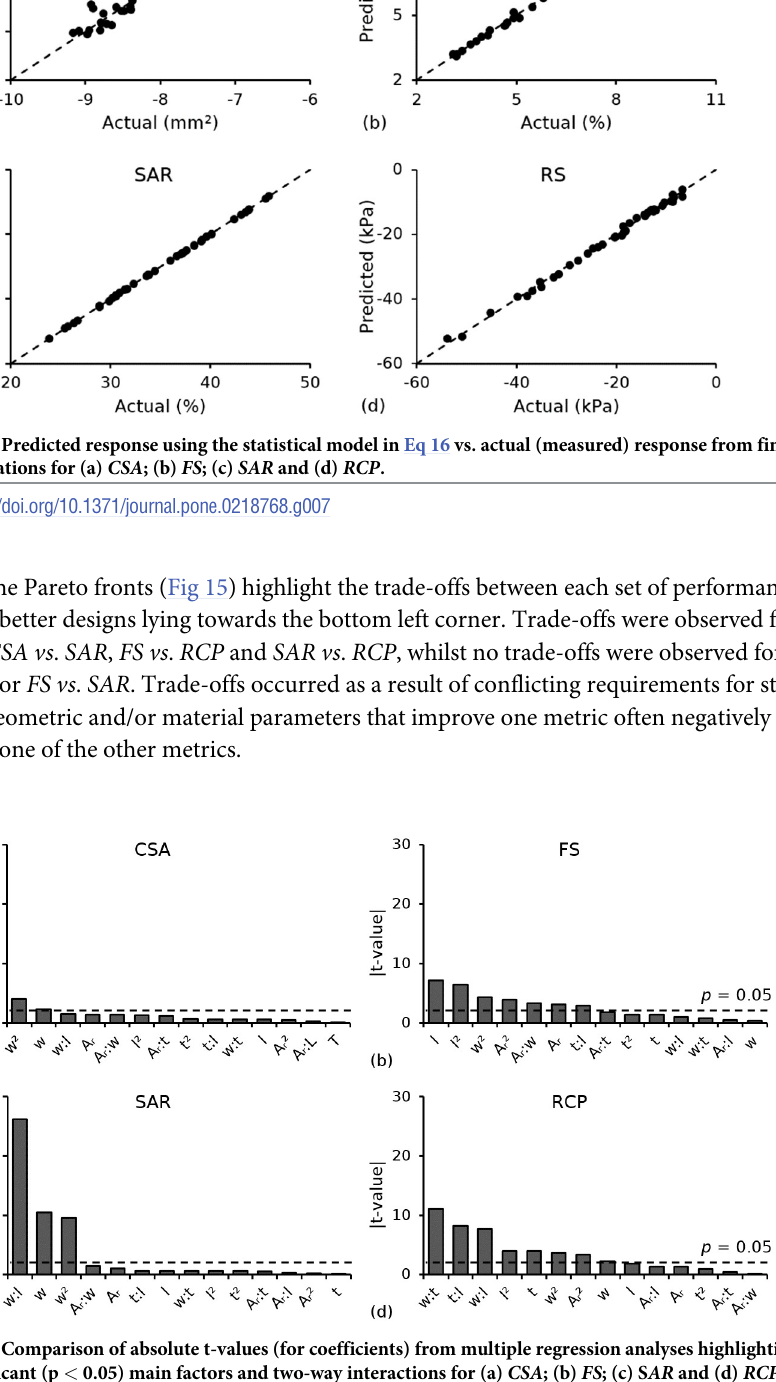
Fig 8. Comparison of absolute t-values (for coefficients) from multiple regression analyses highlighting significant (p < 0.05) main factors and two-way interactions for (a) CSA ; (b) FS ; (c) S AR and (d) RCP .